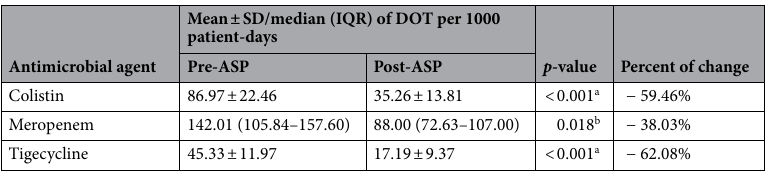
Table 1. Days of therapy (DOT) per 1000 patient-days for the selected antibiotics during the two phases of the study (pre- and post-intervention). DOT days of therapy, ASP antibiotic stewardship program, SD standard deviation. a Analyzed using independent sample t-test. b Analyzed using the Mann–Whitney U